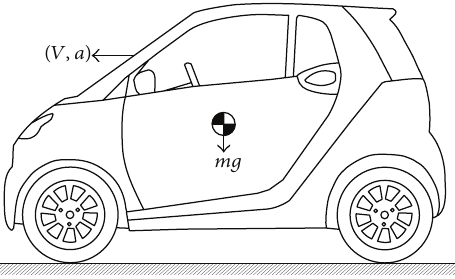
Figure 4: Vehicle